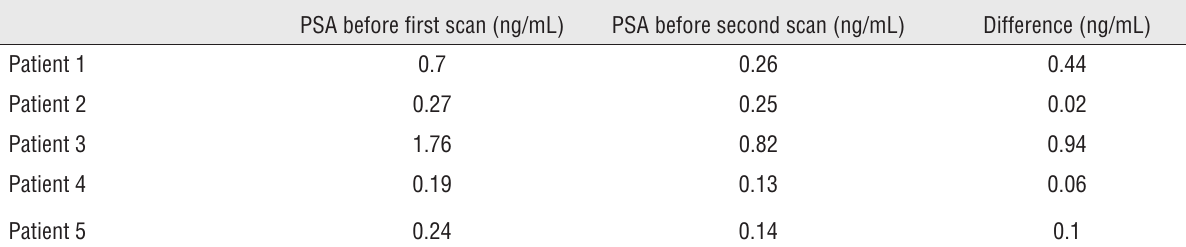
Table 4 - PSA-Levels.